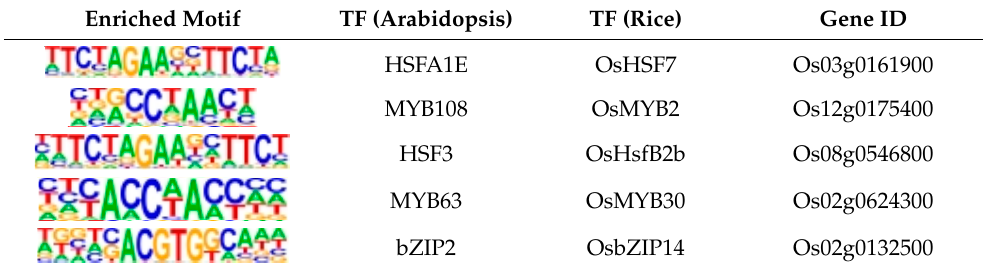
Table 1. Heat-specific enriched motifs and their binding TFs in rice.